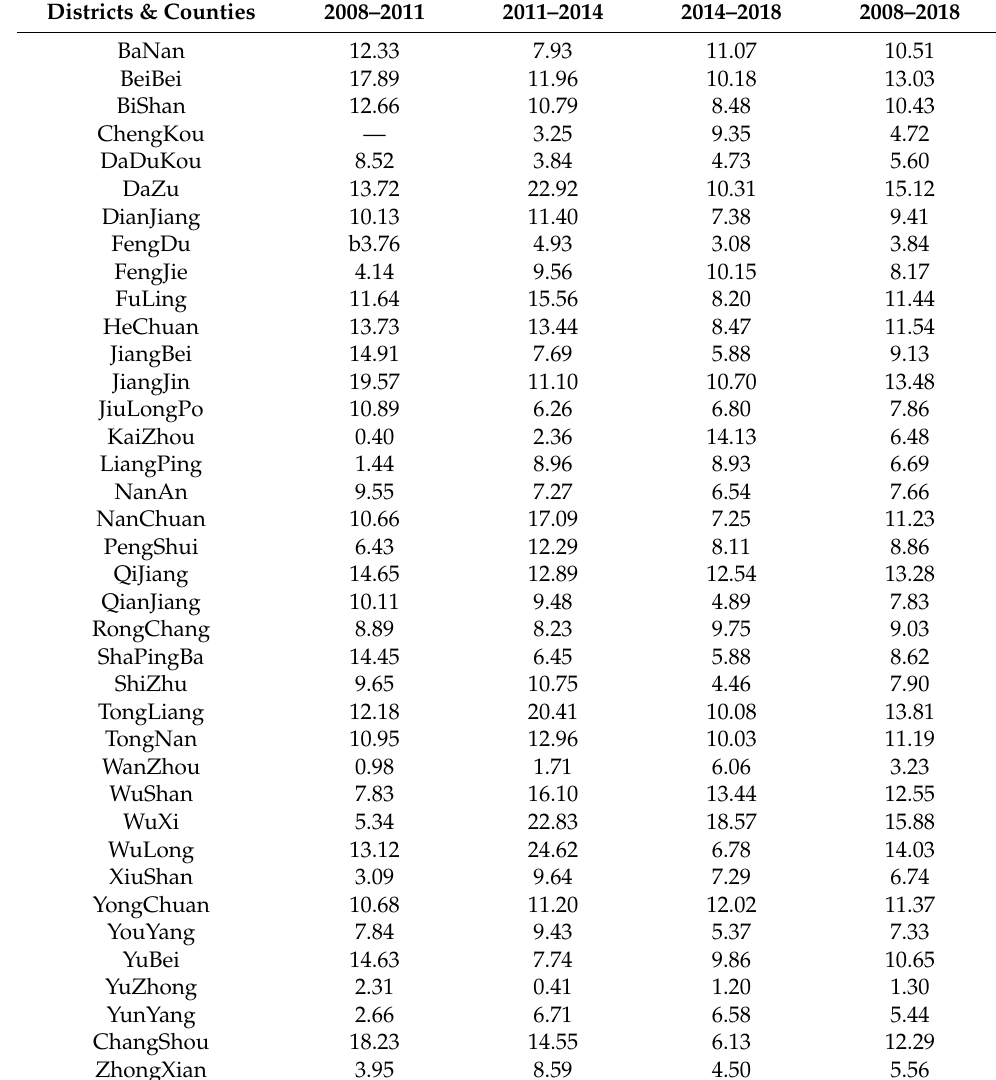
Table 2. Temporal dynamics of the urban land increase rate in Chongqing